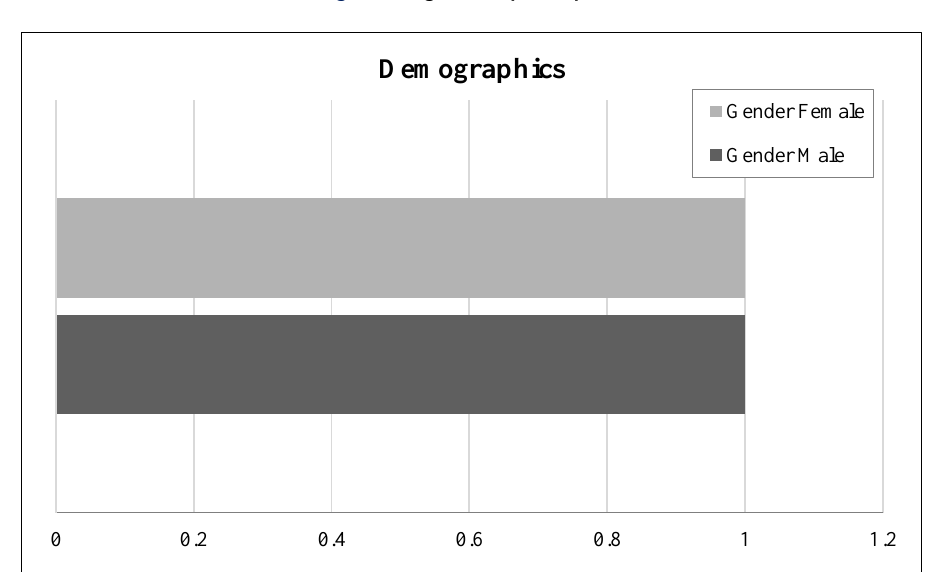
Figure 7. Gender of the participants